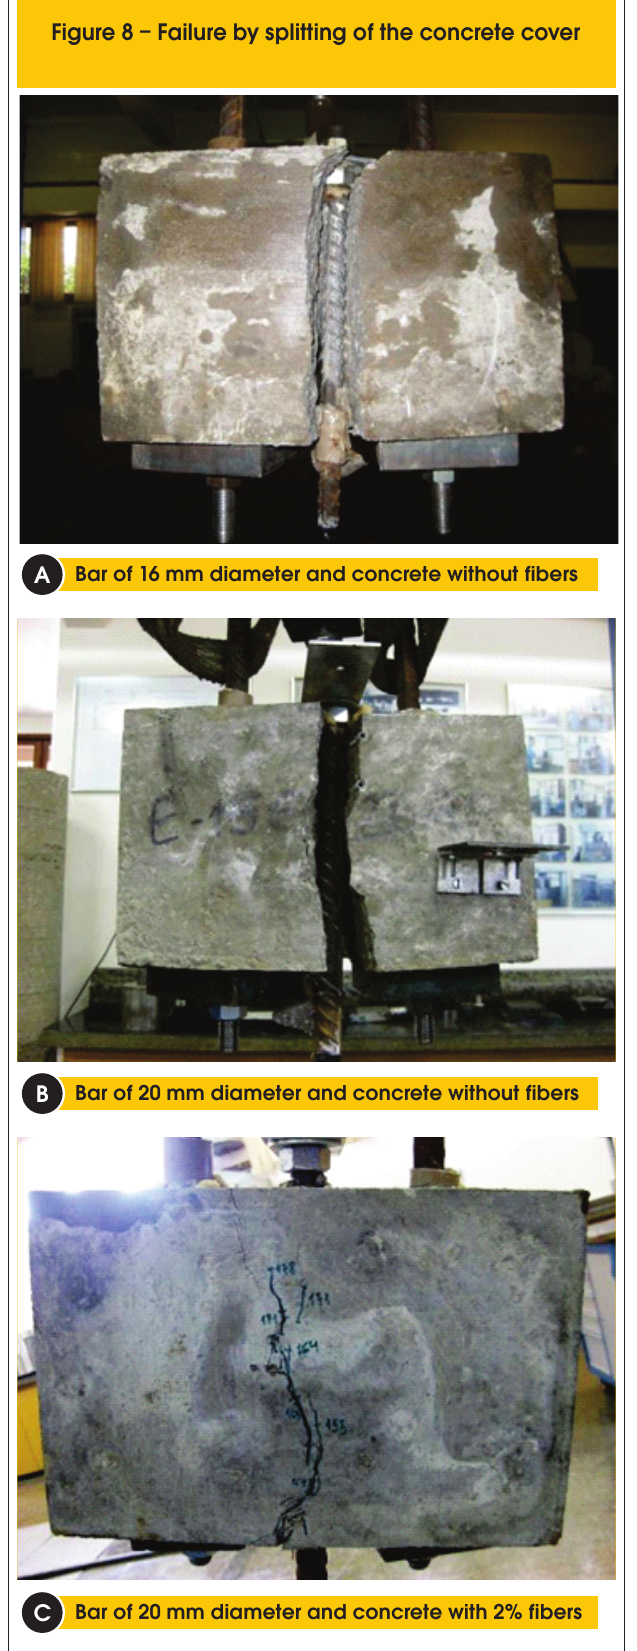
Figure 8 – Failure by splitting of the concrete cover